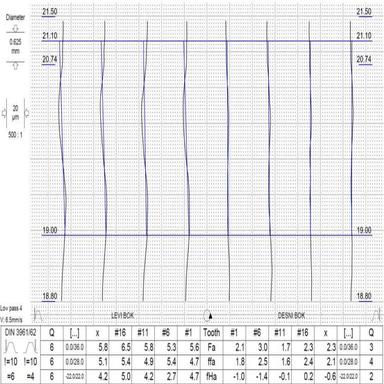
Standardised flank measurement of the steel gear on CMM.